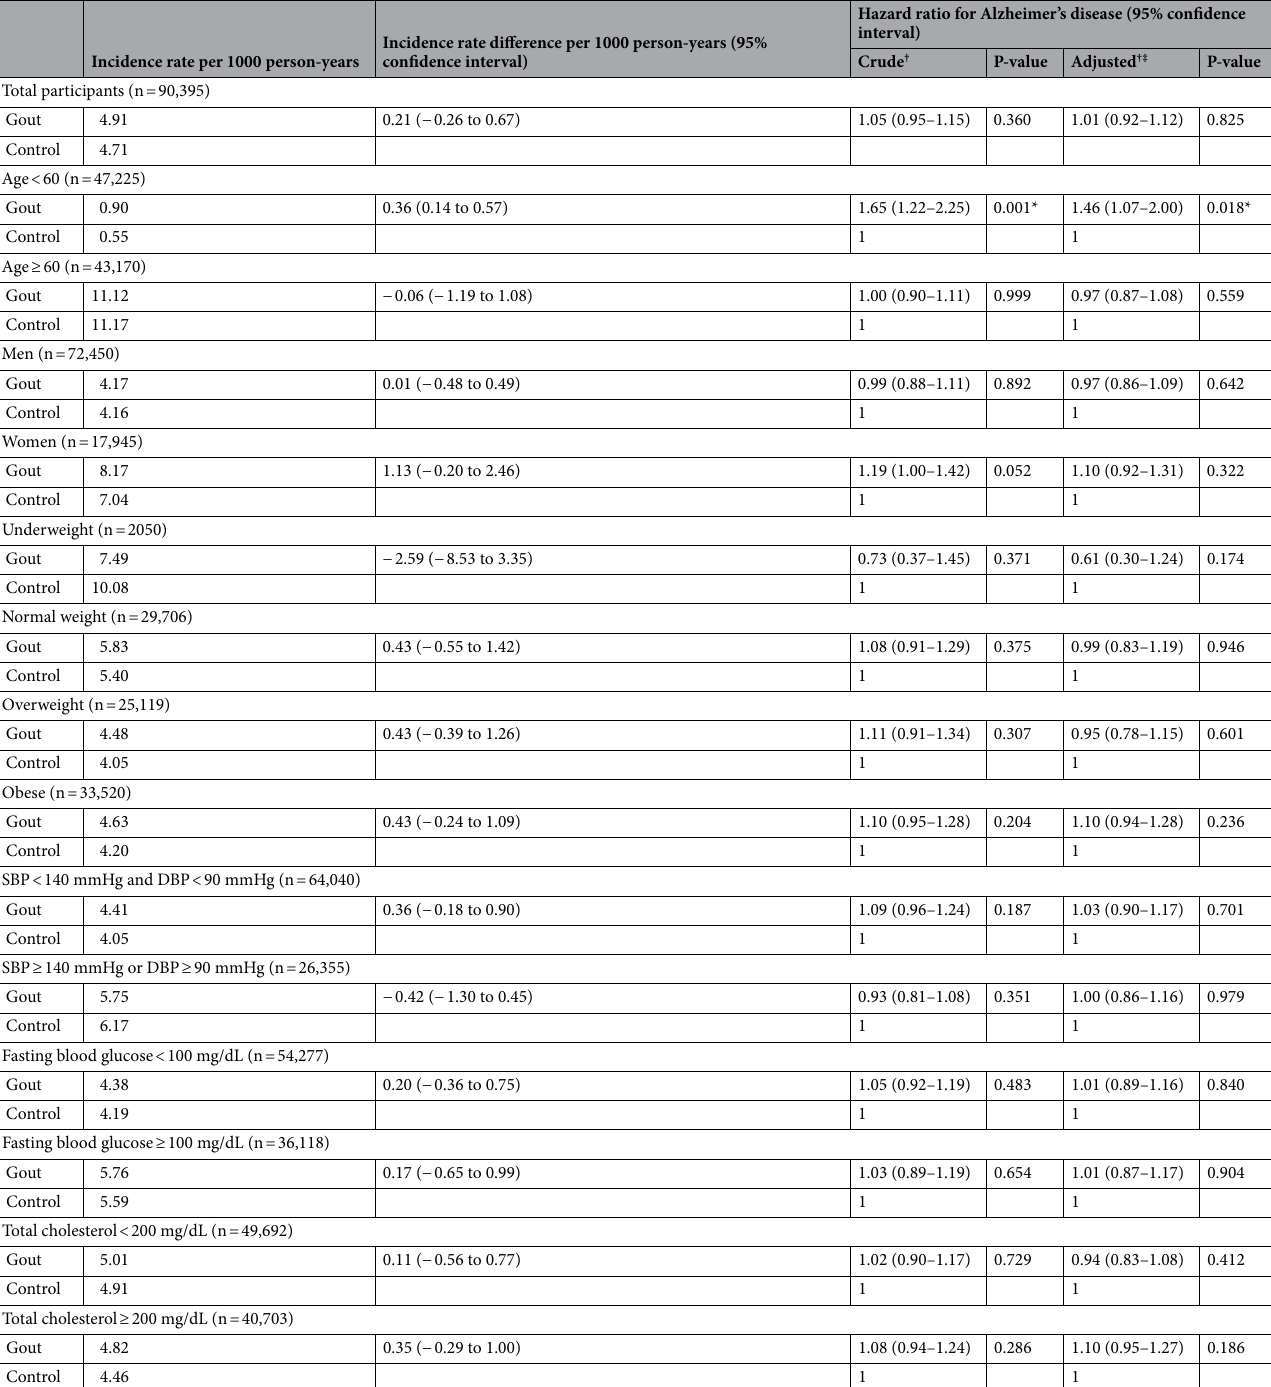
Table 2. Crude and adjusted hazard ratios of gout for Alzheimer’s disease with subgroup analyses stratified based on covariates. SBP systolic blood pressure, DBP diastolic blood pressure. *Stratified or unstratified cox proportional hazard regression model, Significance at P < 0.05. † Matched model based one age, sex, income, and residential area. ‡ Adjusted for obesity, smoking status, alcohol consumption, SBP, DBP, fasting blood glucose, total cholesterol, Charlson comorbidity index scores, and Parkinson’s